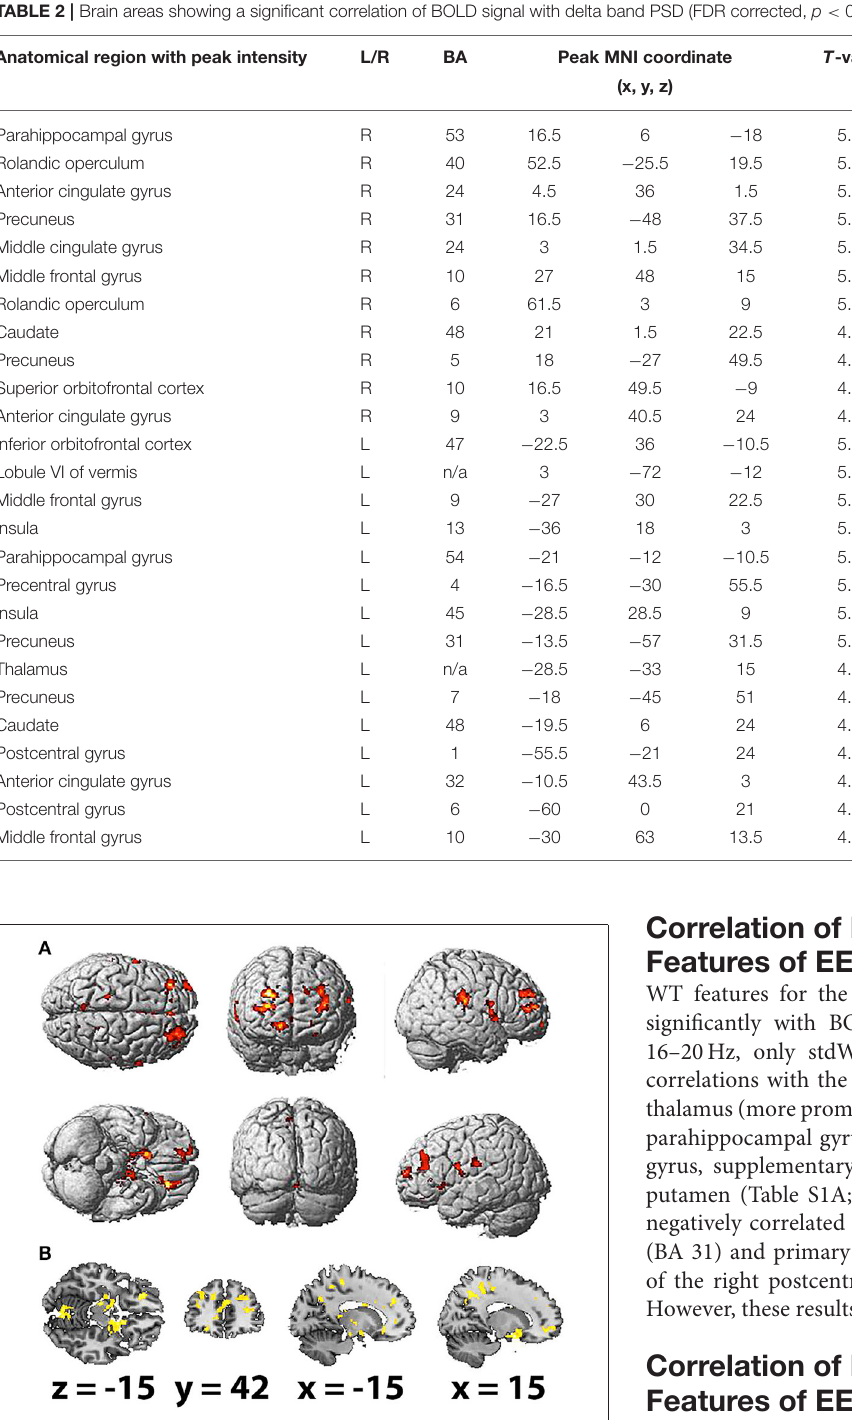
FIGURE 2 | Spatial brain maps with brain areas highlighted in which the BOLD signal increase showed a positive relation with delta power’s spectral density, superimposed on (A) normalized surface in three projections and (B) the scalp-stripped version of the average T1-weighted template image at the three most informative orthogonal slices in neurological convention (left = right). Activation (FDR corrected, p < 0.05, T < 3.47, cluster threshold > 100) is displayed in a gradient from red to yellow (3 < t <